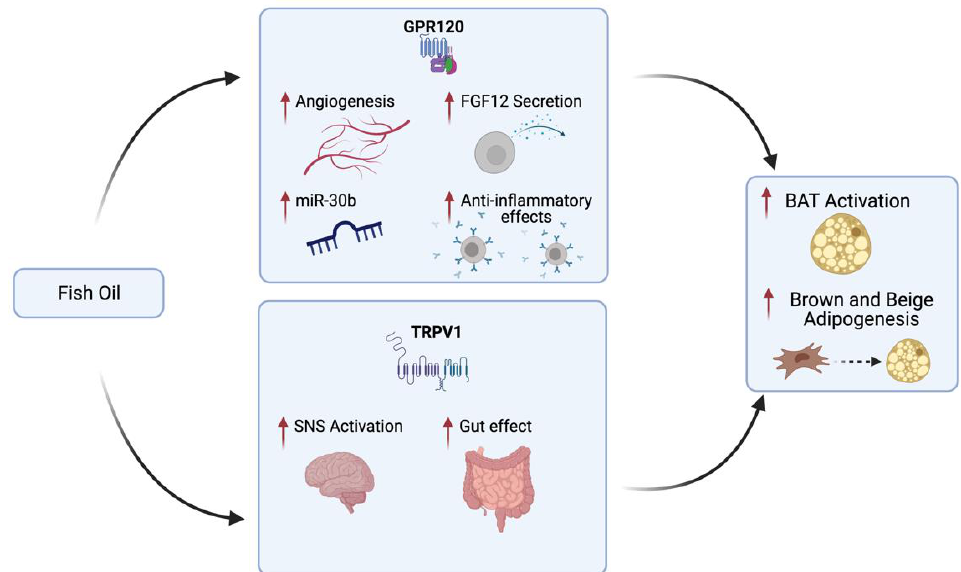
Figure 3. Fish oil mechanism promoting brown adipose tissue (BAT) activation and brown and beige adipogenesis in vivo. Fish oil activates TRPV1 in the gastrointestinal tract and consequently stimulates the sympathetic nerves that innervate the fat cells, causing adipose thermogenesis through β 2-adrenoreceptors. Furthermore, fish oil acting as a ligand of GPR120 induces several effects on adipocytes such as secretion of FGF21 and VEGF-A (which promotes angiogenesis and anti-inflammatory effects through activation of immune cells) and expression of miR-30b [200]. Made by © BioRender